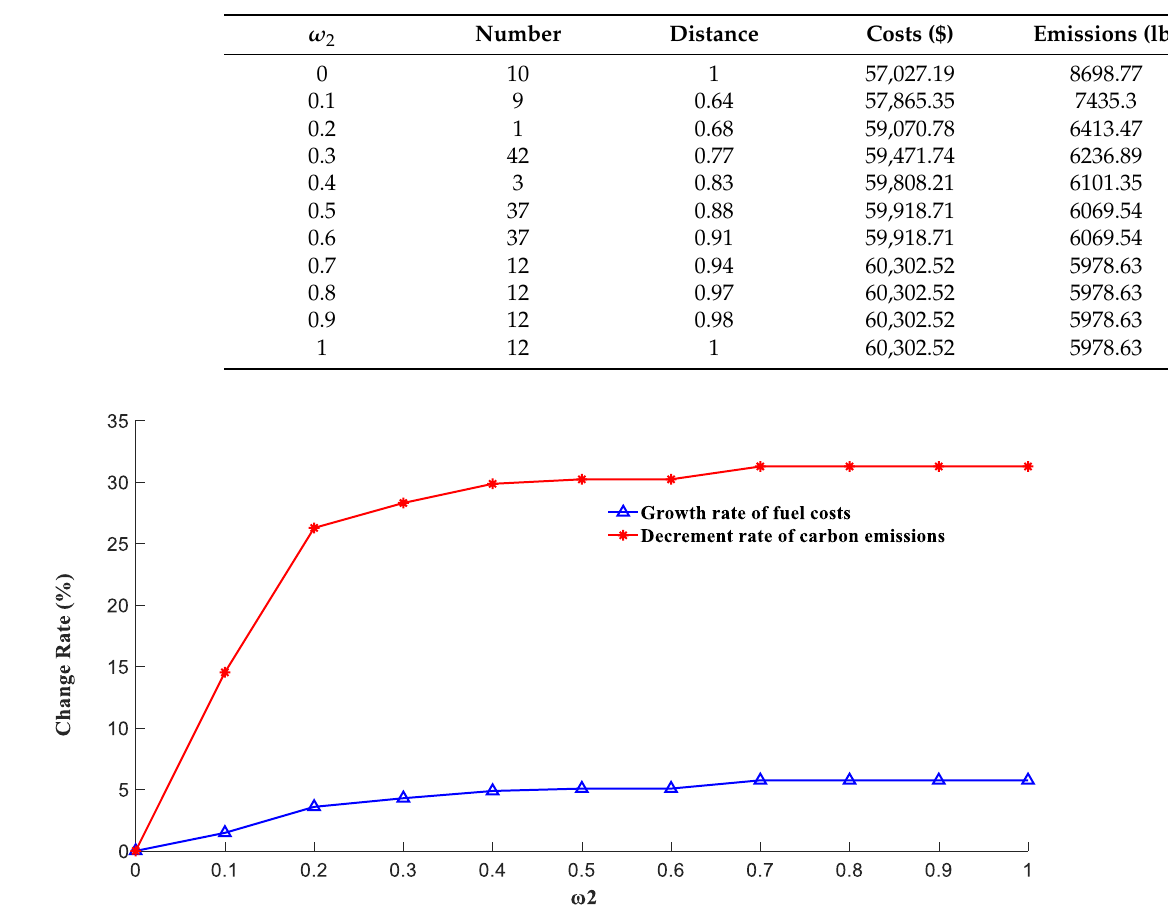
 and the rate of change of the costs and emissions. Figure 3. Correlations between ω 2 and the rate of change of the costs and 2